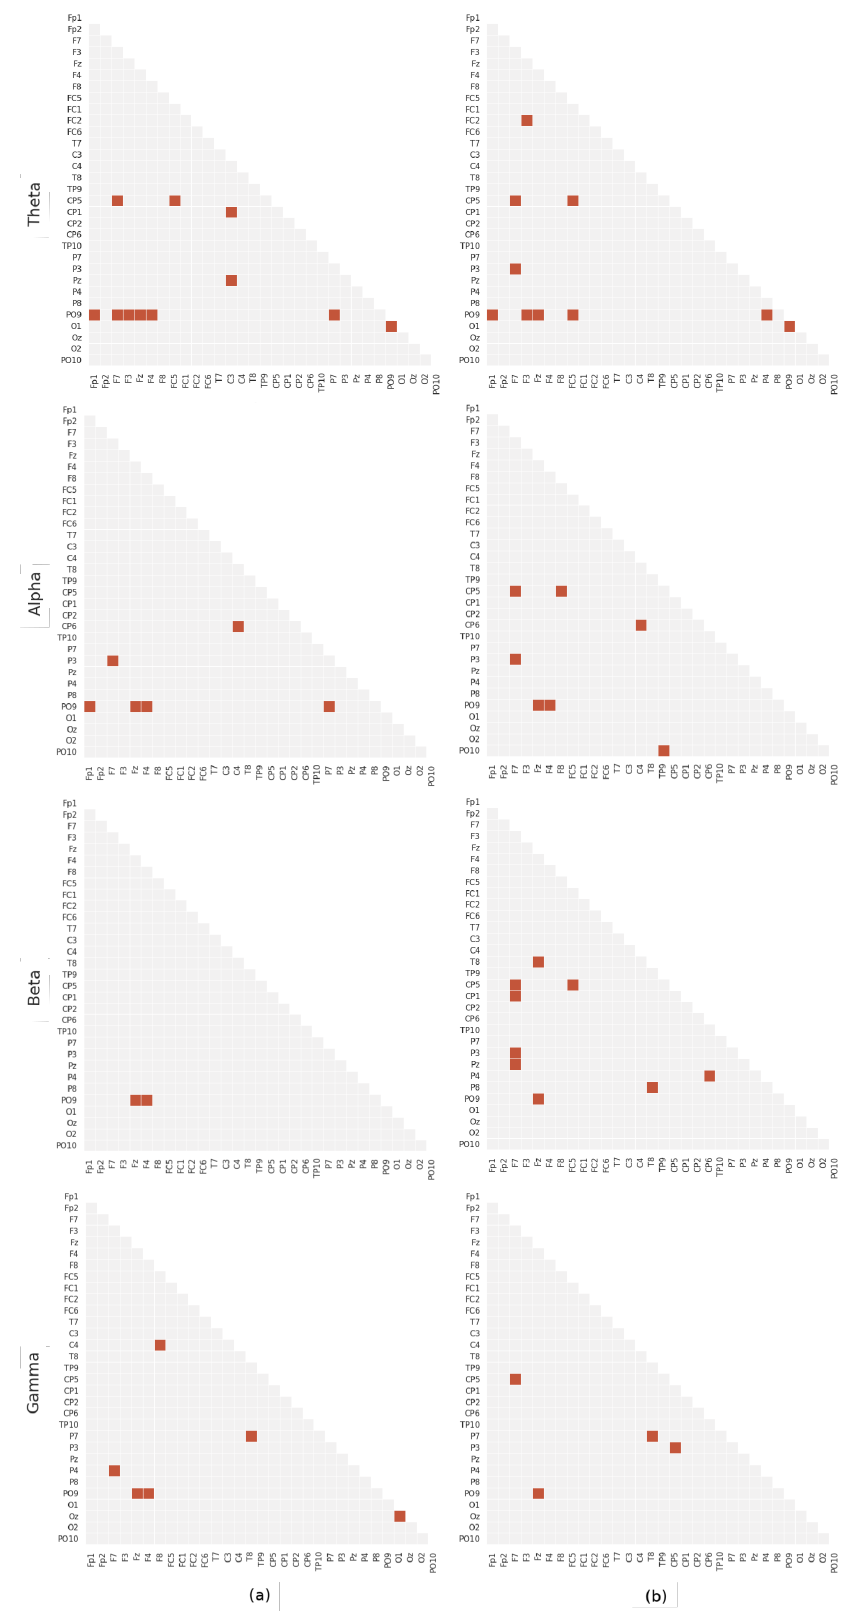
Figure 5. Statistically significant connections for meaningful bands. The axes represent the channels names according to the extended 10–20 EEG montage. Only connections with FDR-corrected p < 0.01 are shown. The ( a ) 4.8Hz and ( b )16 Hz